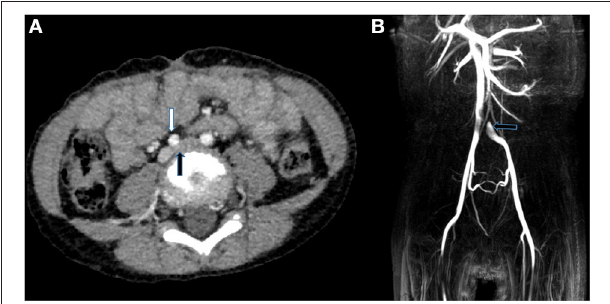
FIGURE 2 | (A) CTA in the transverse plane showed the left common iliac vein (black arrows) was compressed between the right common iliac artery (white arrow) and the lumbar vertebral body. (B) MRI images indicated that there was filling defect where the left common iliac vein merged into the right common iliac vein.